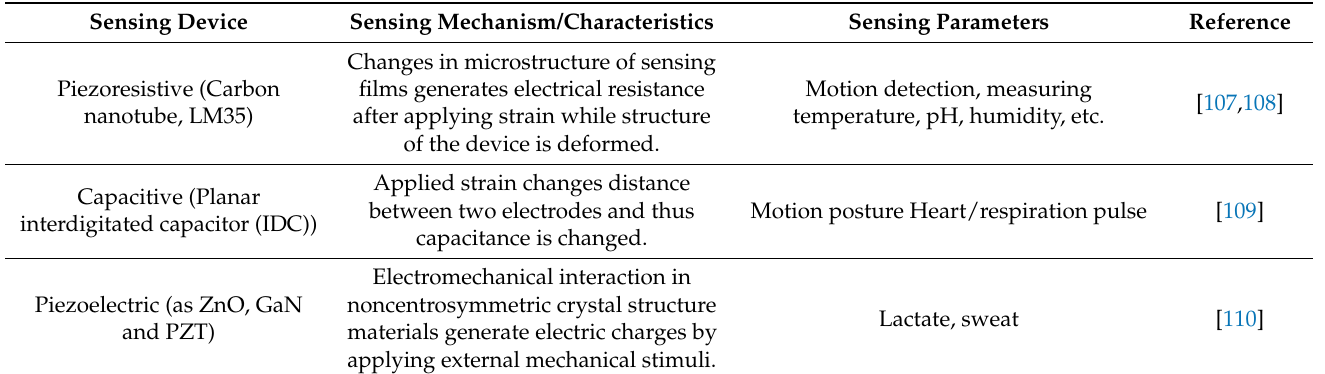
Table 3. Different physiological parameters and their sensing